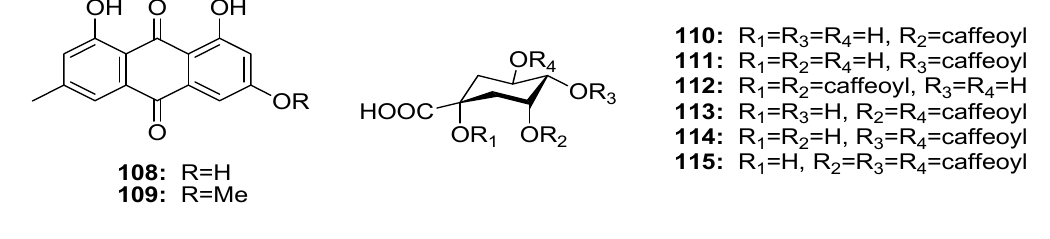
Figure 6. Chemical structures of anthraquinones and caffeoylquinic acid derivatives isolated from the genus Gnaphalium .